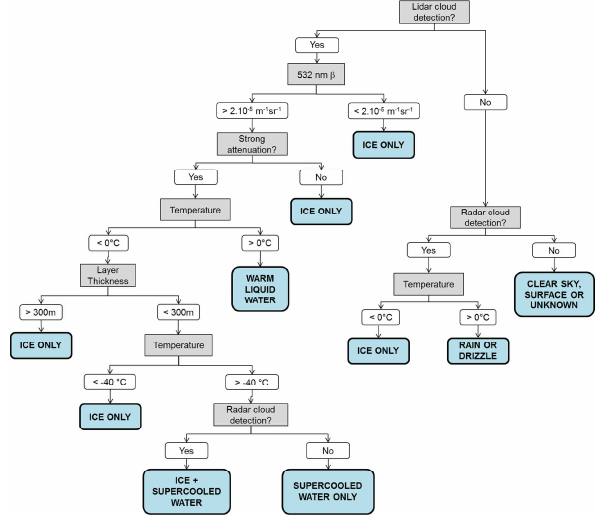
Figure 1. Representation of the DARDAR algorithm retrieval steps for cloud thermodynamic phase.